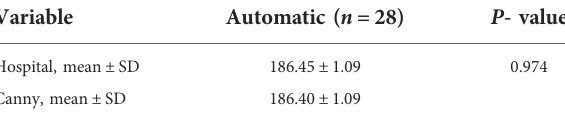
TABLE 2 The mean compared to the standard deviation for auto- calculated HKA angles using t -test for both images obtained from the hospital that were constructed by an expert and others stitched using our method based on canny.